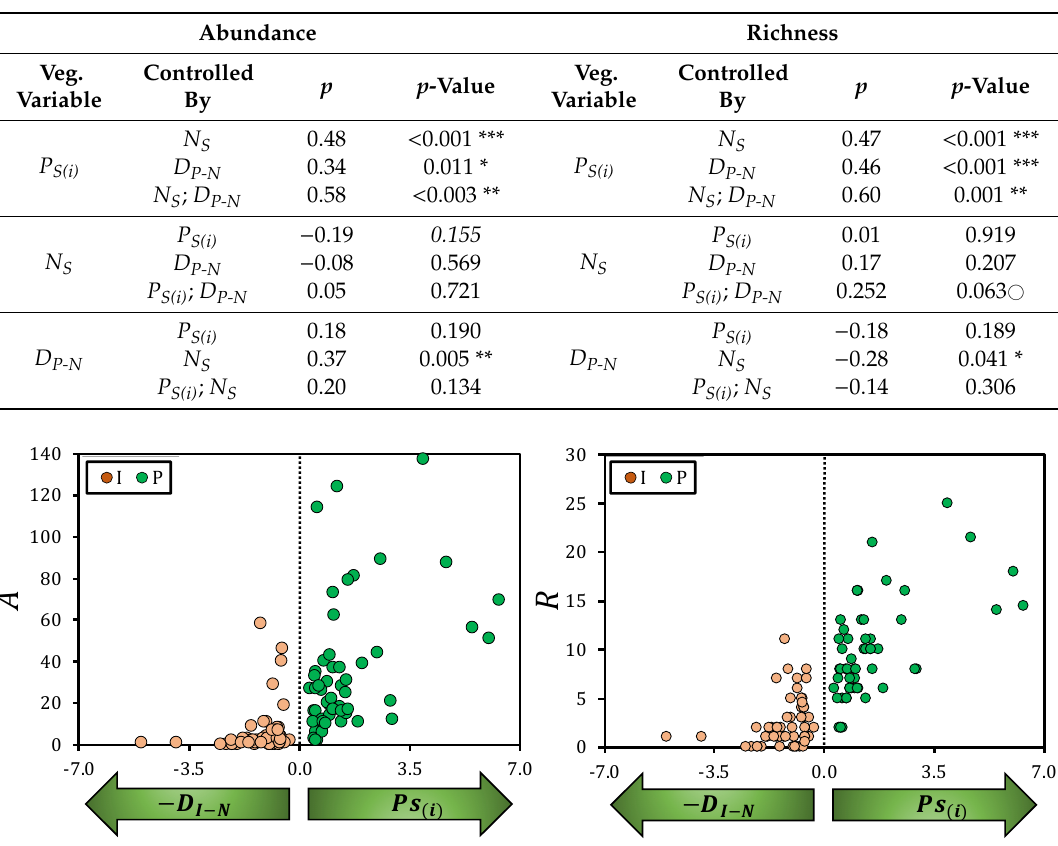
Figure 4. Spatial distribution of the abundance ( A , left panel) and species richness ( R , right panel) of ground arthropods observed in interpatches ( I ) and patches ( P ) sampling points in a semiarid steppe as a function of the average distance between the interpatch points and the neighbor patches (represented as negative values: − D I-N ) and the patch size ( P S(i) ), both metric measured in meters. The green arrows indicate the direction of increase for which each pattern metric.